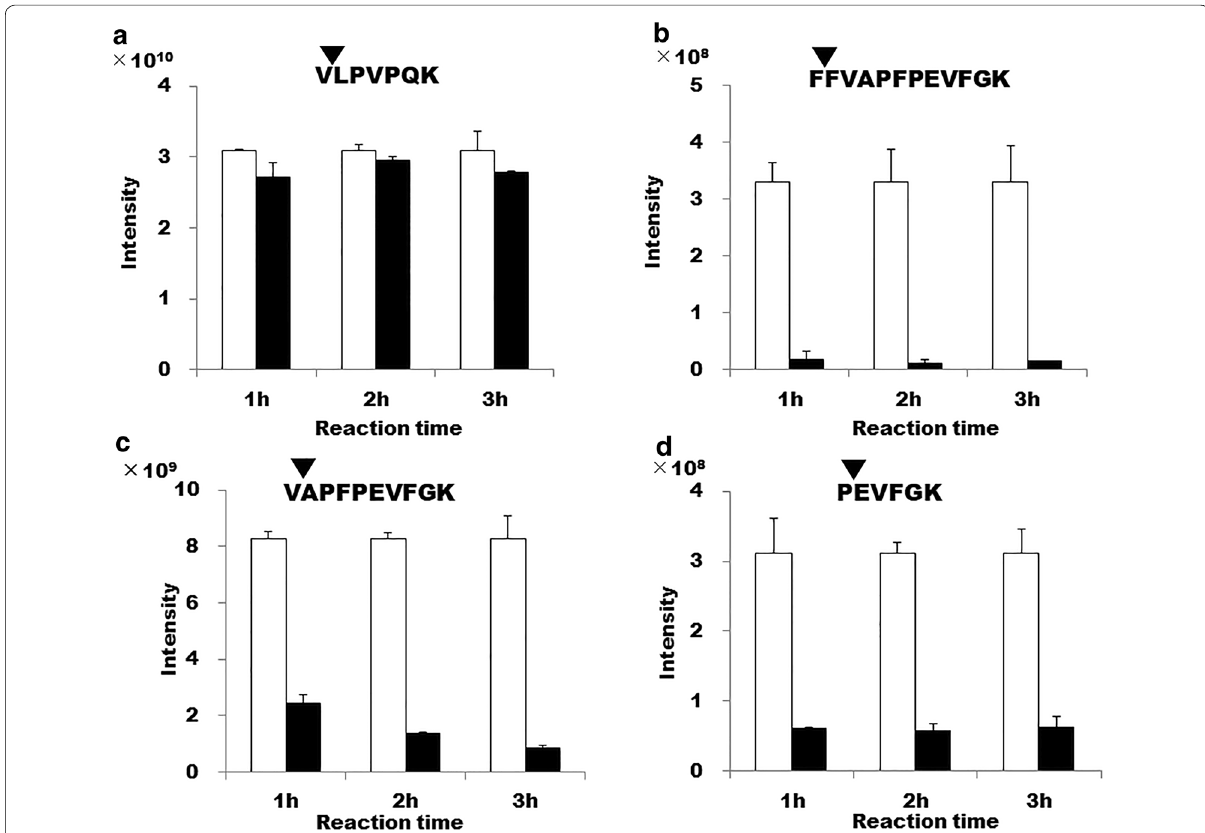
Fig. 2 Evaluation of XPO DUET during the degradation of tryptic casein. a The contents of VLPVPQK, as determined by LC–MS analysis. b The contents of FFVAPFPEVFGK, as determined by LC–MS analysis. c The contents of VAPFPEVFGK, as analyzed with LC–MS. d The contents of PEVFGK, as determined with LC–MS analysis. The white and black columns indicate tryptic digestion and treatment with XPO DUET,